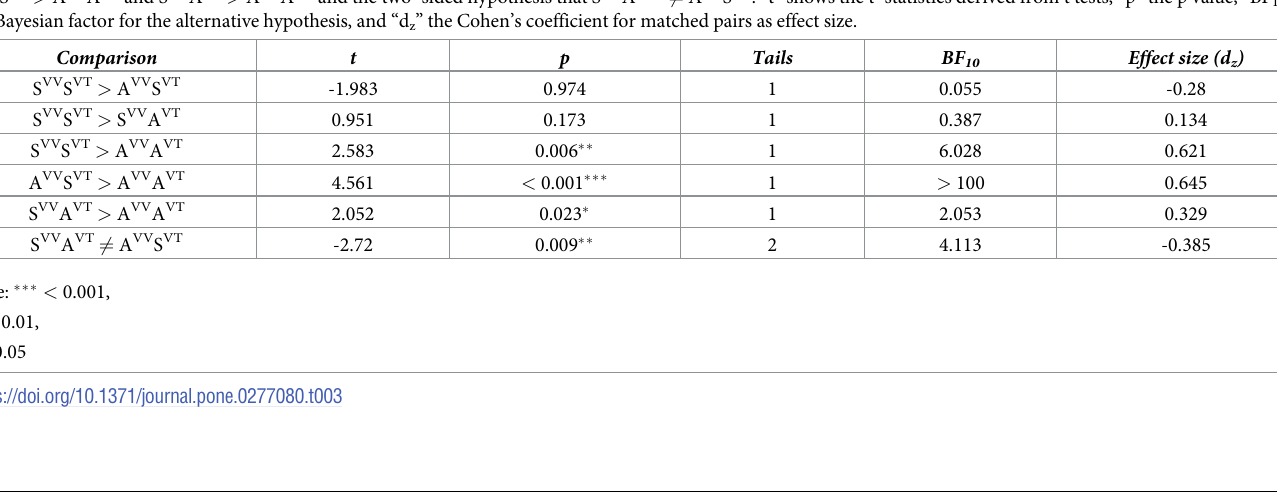
Table 3. Skin conductance response magnitude results (N = 50). We tested the one–sided hypotheses that S VV S VT > A VV S VT , S VV S VT > S VV A VT , S VV S VT > A VV A VT ,